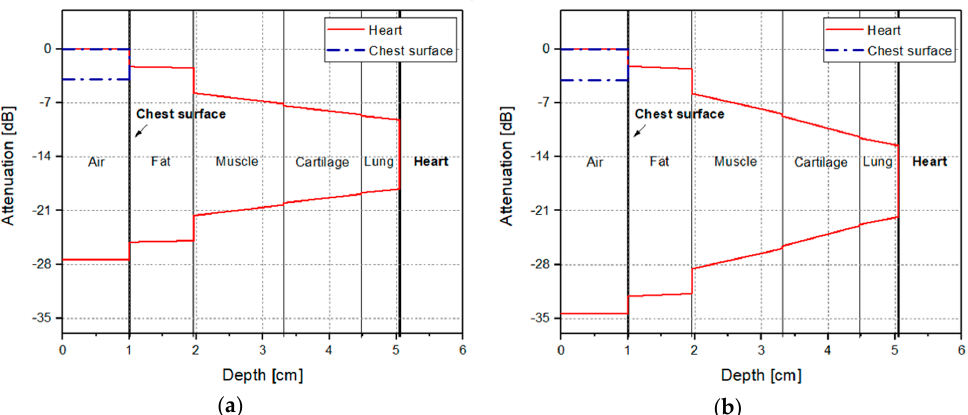
Figure 2. Calculated path loss in human-body layers depending on frequency: ( a ) 915 MHz and ( b ) 2.45 GHz.